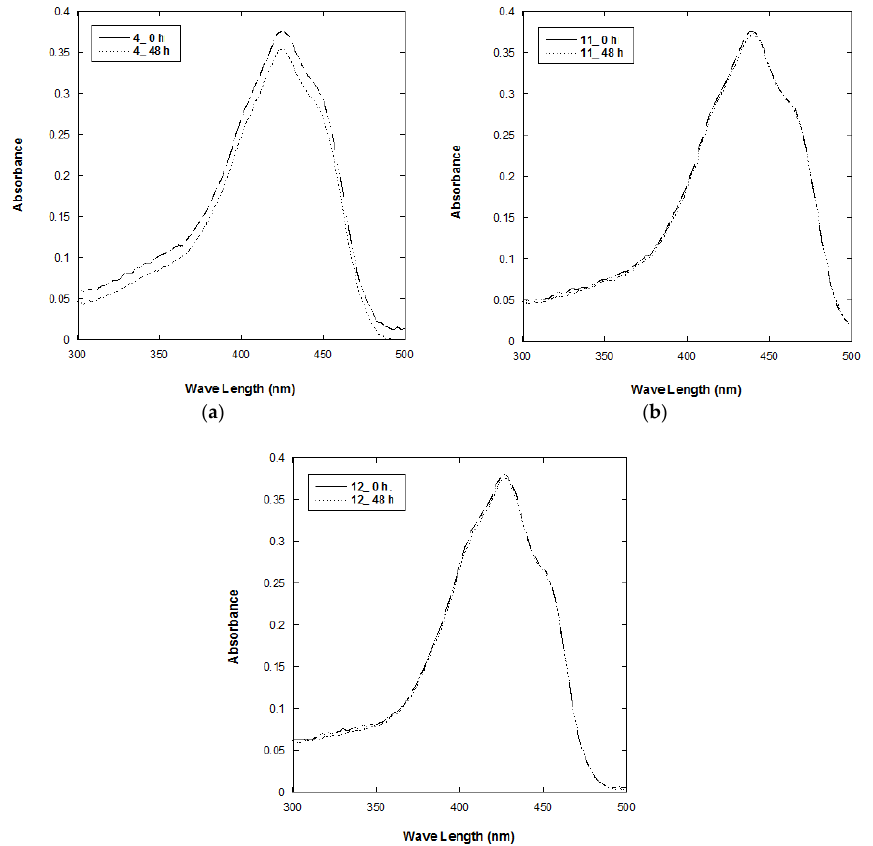
Figure 4. Absorptionspectraof( a )compound 4 (20ppm), ( b )compound 11 (20ppm), and( c )compound 12 (20 ppm), before and after storage in the dark for 48